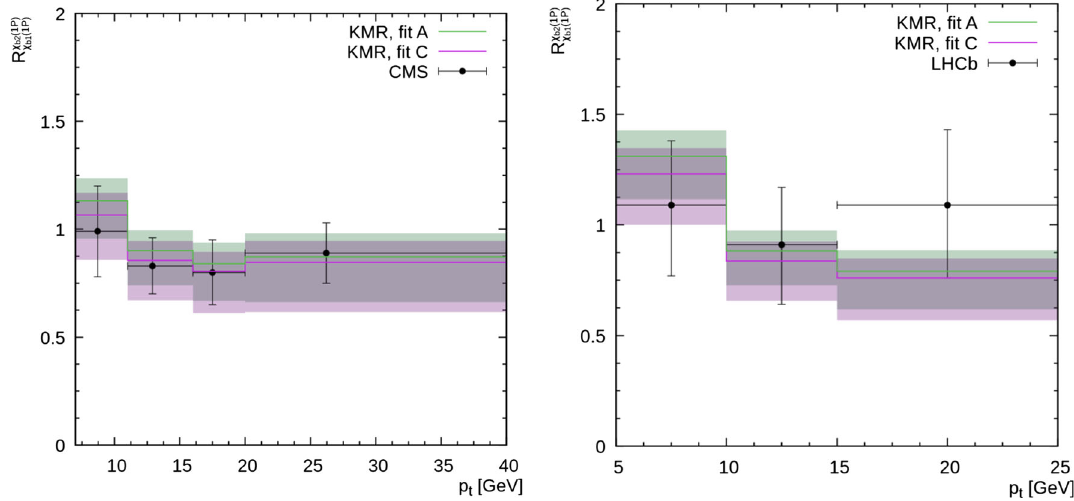
√ s = 8 TeV. The notation of all histograms